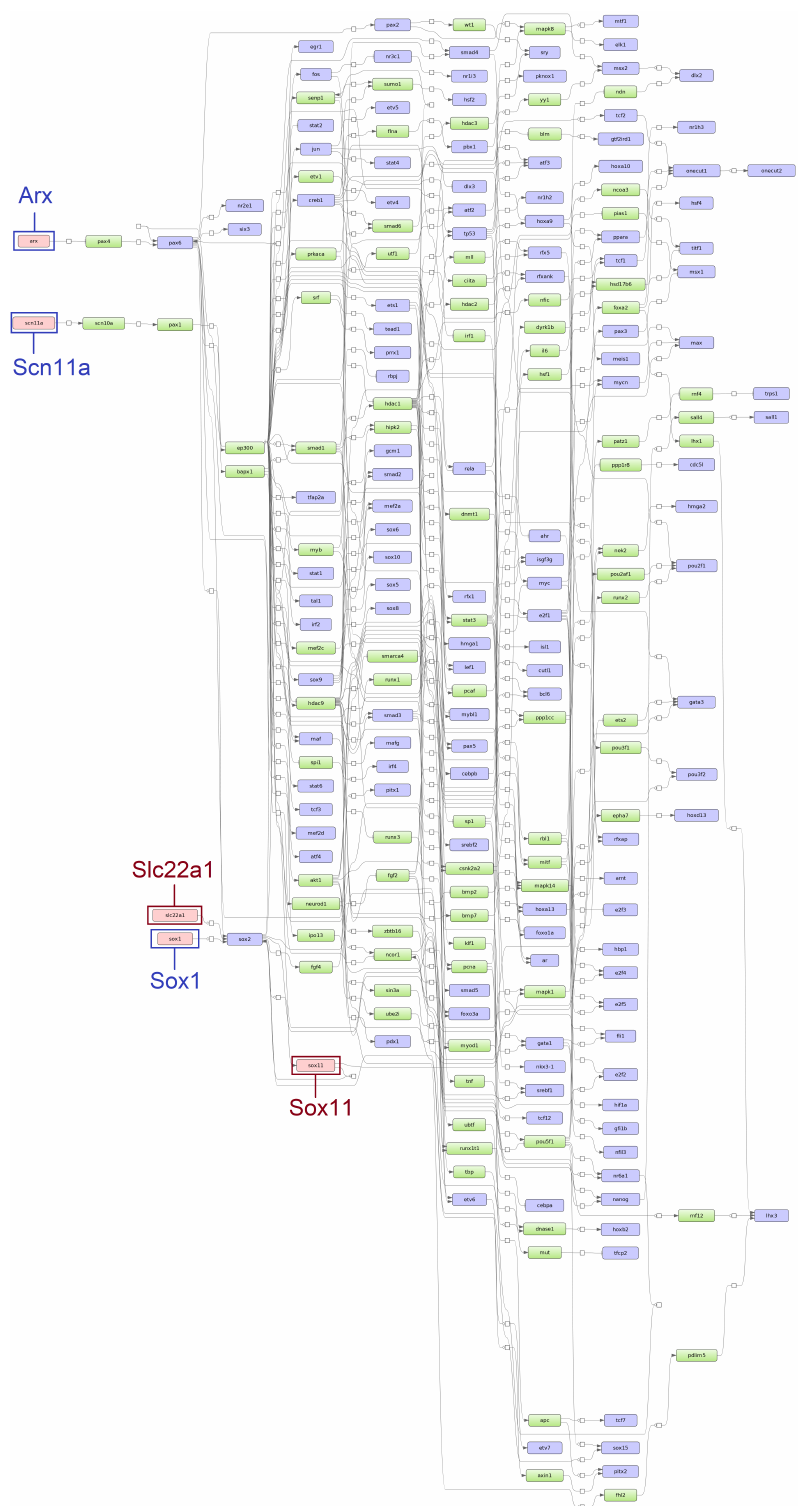
Figure 5. Scheme of gene regulatory pathways revealing the top five master regulators (pink filled boxes) for eggshell strength at Time Point 1 (ESS1) following the “upstream analysis” [42]. The master regulators written in dark blue and surrounded by dark blue boxes ( Arx, Scn11a and Sox1 ) were identified specifically for ESS1 while master regulators written in dark red and surrounded by dark red boxes ( Slc22a1 and Sox11 ) were identified at both time points (corresponding networks for eggshell strength at Time Point 2 (ESS2) in Figure